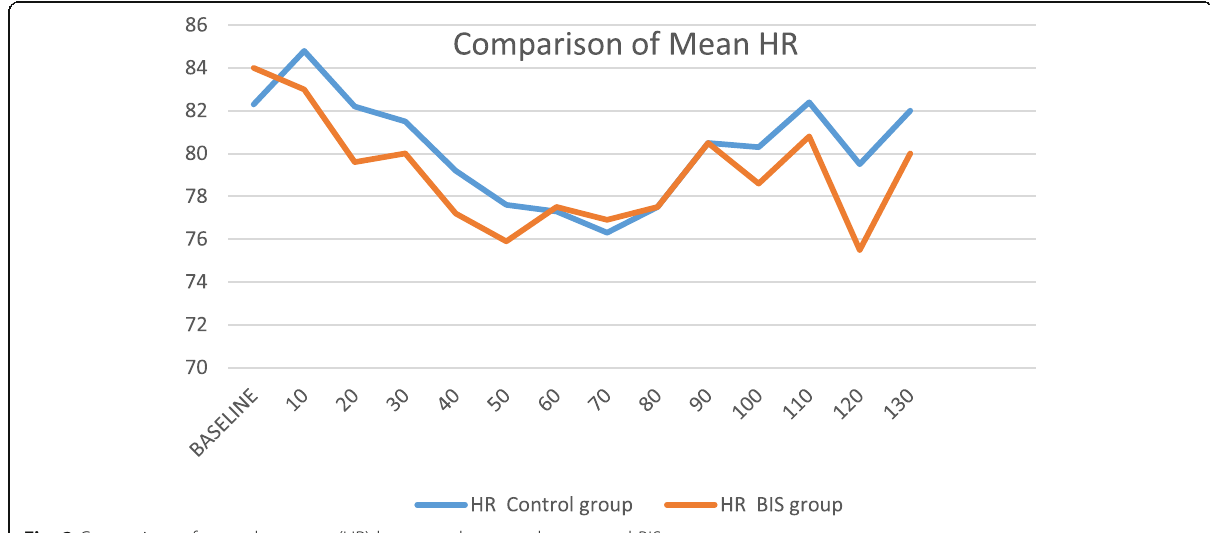
Fig. 2 Comparison of mean heart rate (HR) between the control group and BIS group